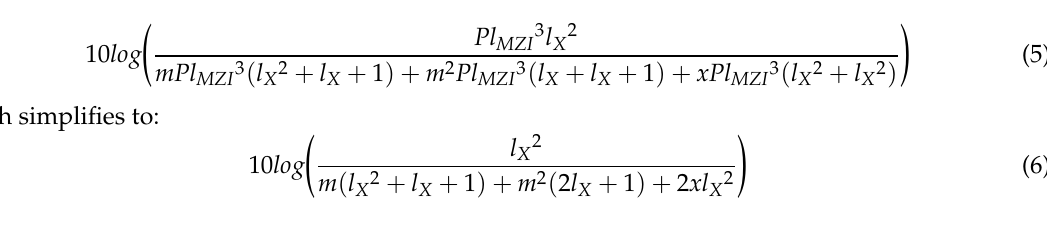
Table 2. Signal and cumulative crosstalk generated by MZIs and by waveguide crossings after each stage, for a 4 × 4 —Beneš when all MZIs are in bare-state. The wanted-signal is written in black, while crosstalk generated by MZI and waveguide crossing are respectively written in blue and red.